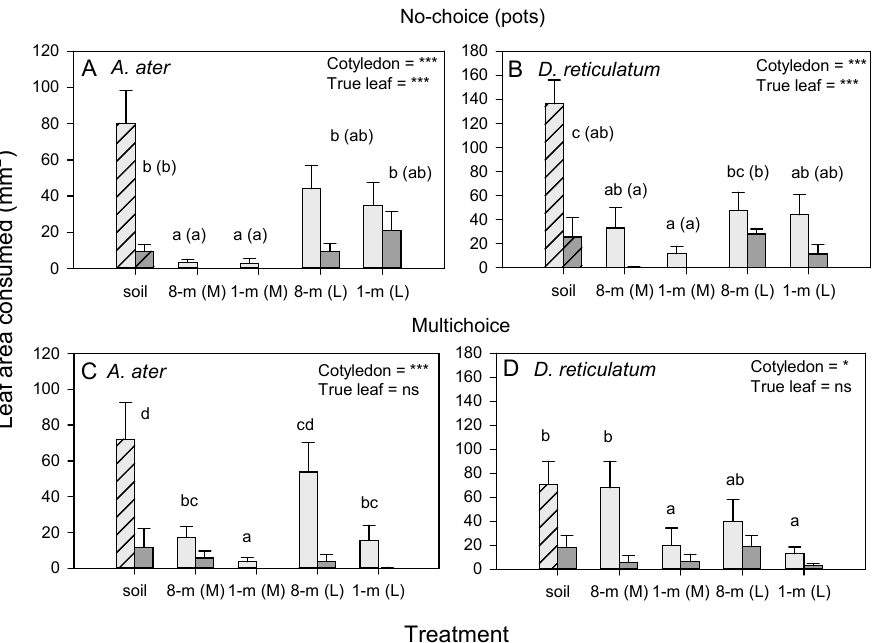
Figure 7. Results from no-choice bioassays with ( A ) A. ater and ( B ) D. reticulatum on radish plants in pots, and from multichoice bioassays with ( C ) A. ater , and ( D ) D. reticulatum on radish plants without soil in arenas. In the no-choice bioassays, radish plants in unamended soil (hatched bars), and soil that had 8- and 1-month-old SCG mixed (M) with soil or added as a layer (L) on top of the soil were exposed to the slugs such that the soil and plant quality affected slug behaviors. In the multichoice bioassays, corresponding plants were exposed without soil. All arenas had both coty- ledon (gray bars) and true leaves (dark gray bars). The results of MANOVA are presented for ar- eas consumed from cotyledons and true leaves as * = p < 0.05 and *** = p < 0.001. Lowercase letters indicate homogenous leaf groups, with groupings for true leaves in parentheses. Standard errors are indicated (N = 6). Plants grown in each soil type as used in the bioassay are described in Figure S1.